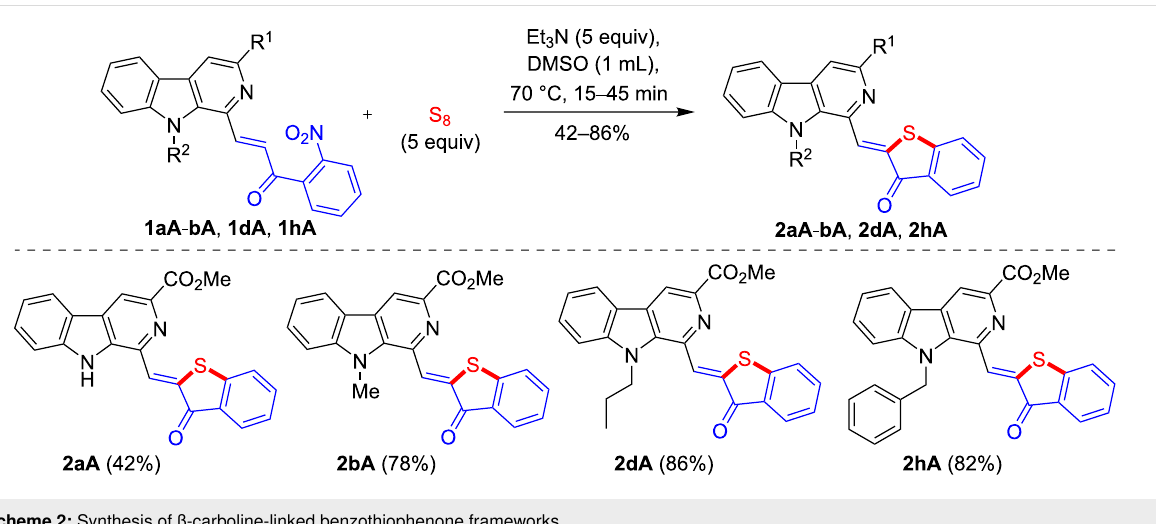
and produced the fluorescent β -carboline-linked